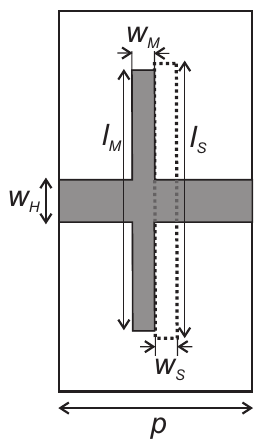
Figure 1: Unit-cell geometry.